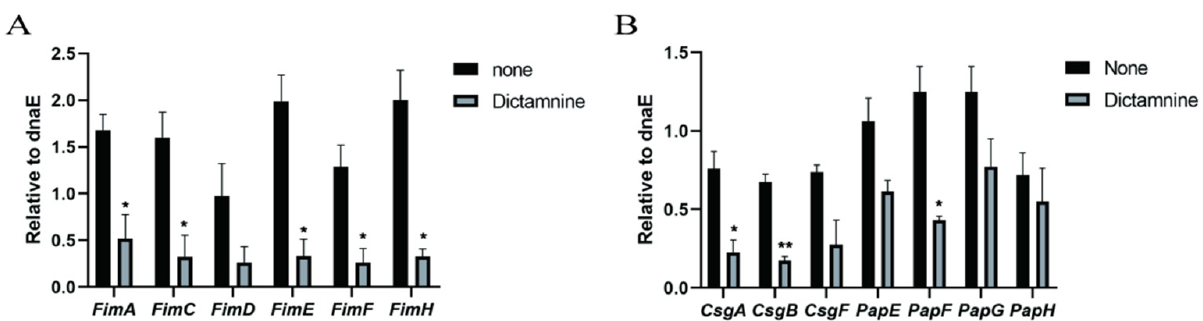
Figure 5. Effects of dictamnine on fimbriae production. Evaluation of expression levels of fimbriae- associated genes by RT-qPCR: ( A ) type 1 fimbriae, ( B ) curli fimbriae and P fimbriae. * p < 0.05, ** p < 0.01.